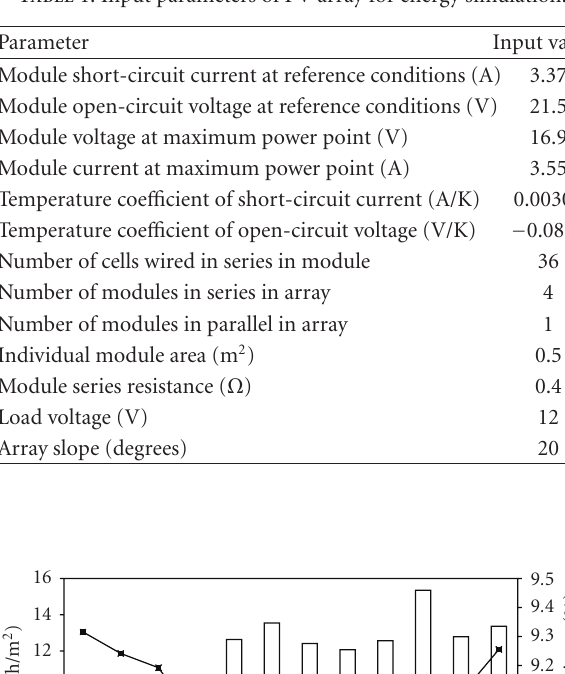
Table 1: Input parameters of PV array for energy simulation.